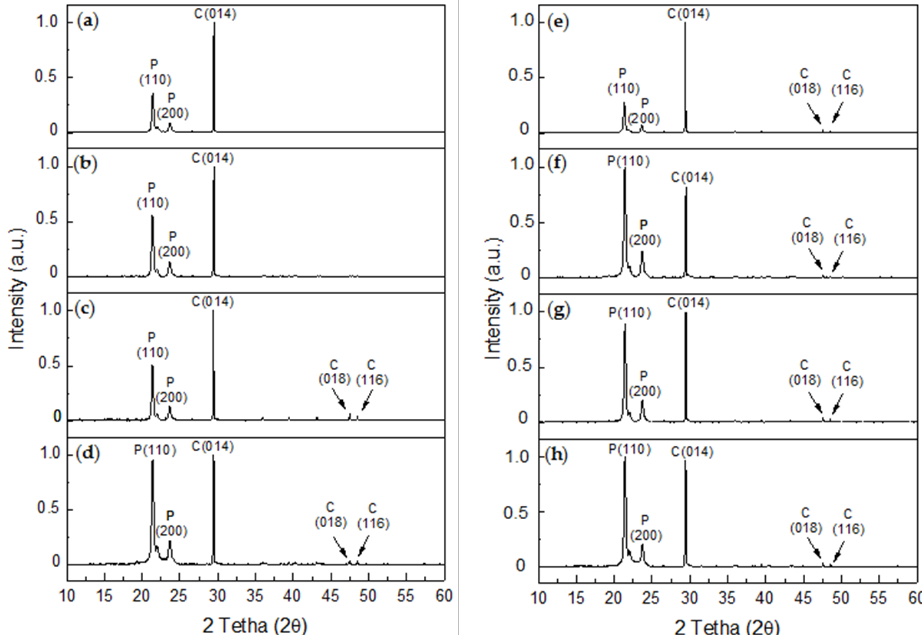
Figure 11. XRD diffractograms of CaCO 3 obtained for GD assays on R-P/G-EPnF and A-P/G-EPnF meshes. ( a ) R-P/G0-EPnF, ( b ) R-P/G0.5-EPnF, ( c ) R-P/G1-EPnF, ( d ) R-P/G2-EPnF, ( e ) A-P/G0-EPnF, ( f ) A-P/G0.5-EPnF, ( g ) A-P/G1-EPnF, and ( h ) A-P/G2-EPnF. The abbreviations of P, C, and V corre- spond to polycaprolactone, calcite, and vaterite,